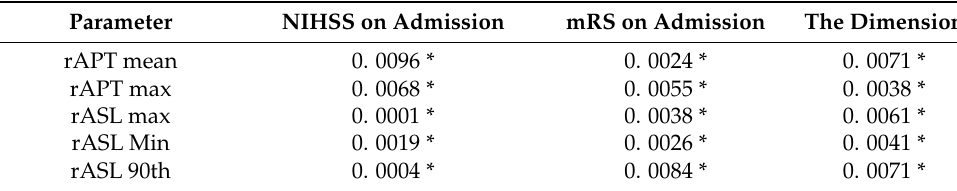
Table 4. The results of multivariate statistical comparison.